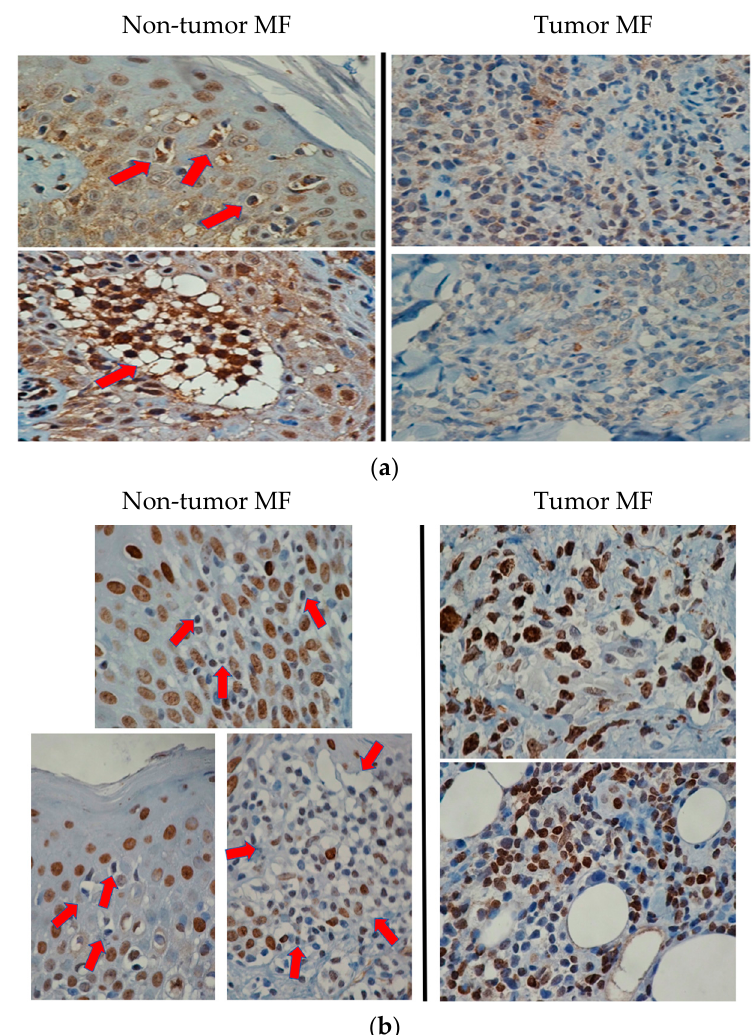
Figure 3. Immunohistochemical validation of SHP2 and HMGA1. ( a ) Immunostaining of SHP2